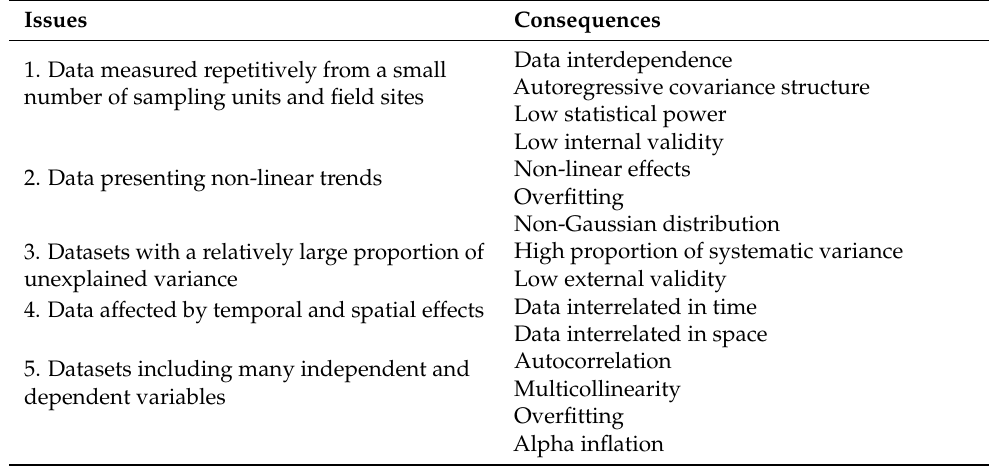
Table 1. Issues and consequences of successional samples or measurements recovered sequentially from a decaying